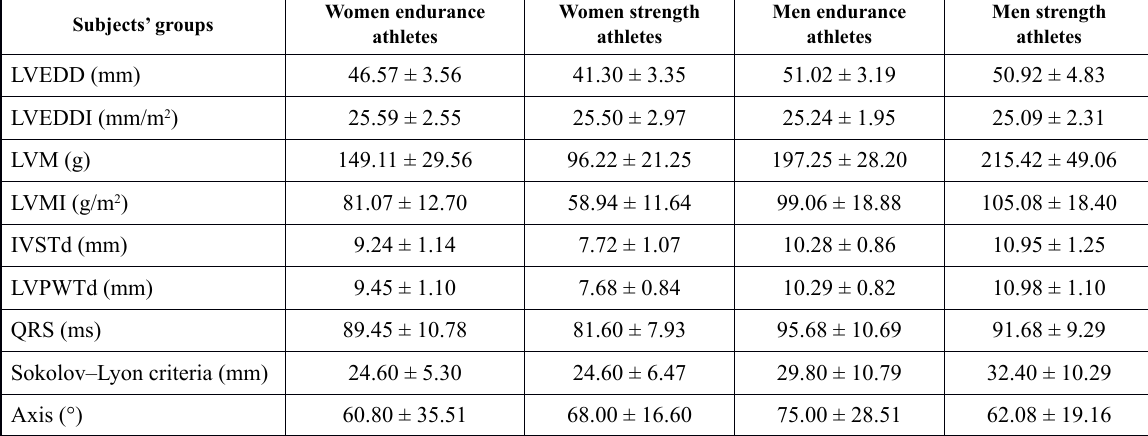
Table 2. LVH ECG an TTE parameters according to gender and physical activity